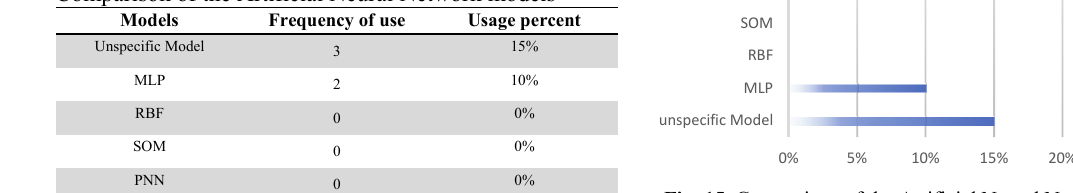
Fig. 15. Comparison of the Artificial Neural Network models